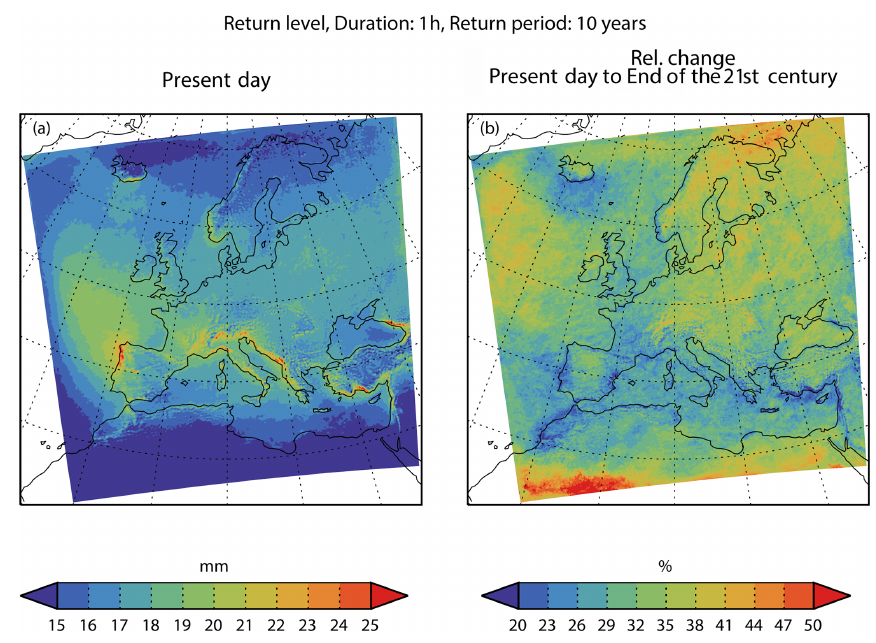
Figure 2. Geographical distribution of the 10-year return level of precipitation intensity for 1h duration for the present-day (a) and relative change from the present-day to end-21st-century (b) . In each grid point, values are the median return level over all 19 model simulations.